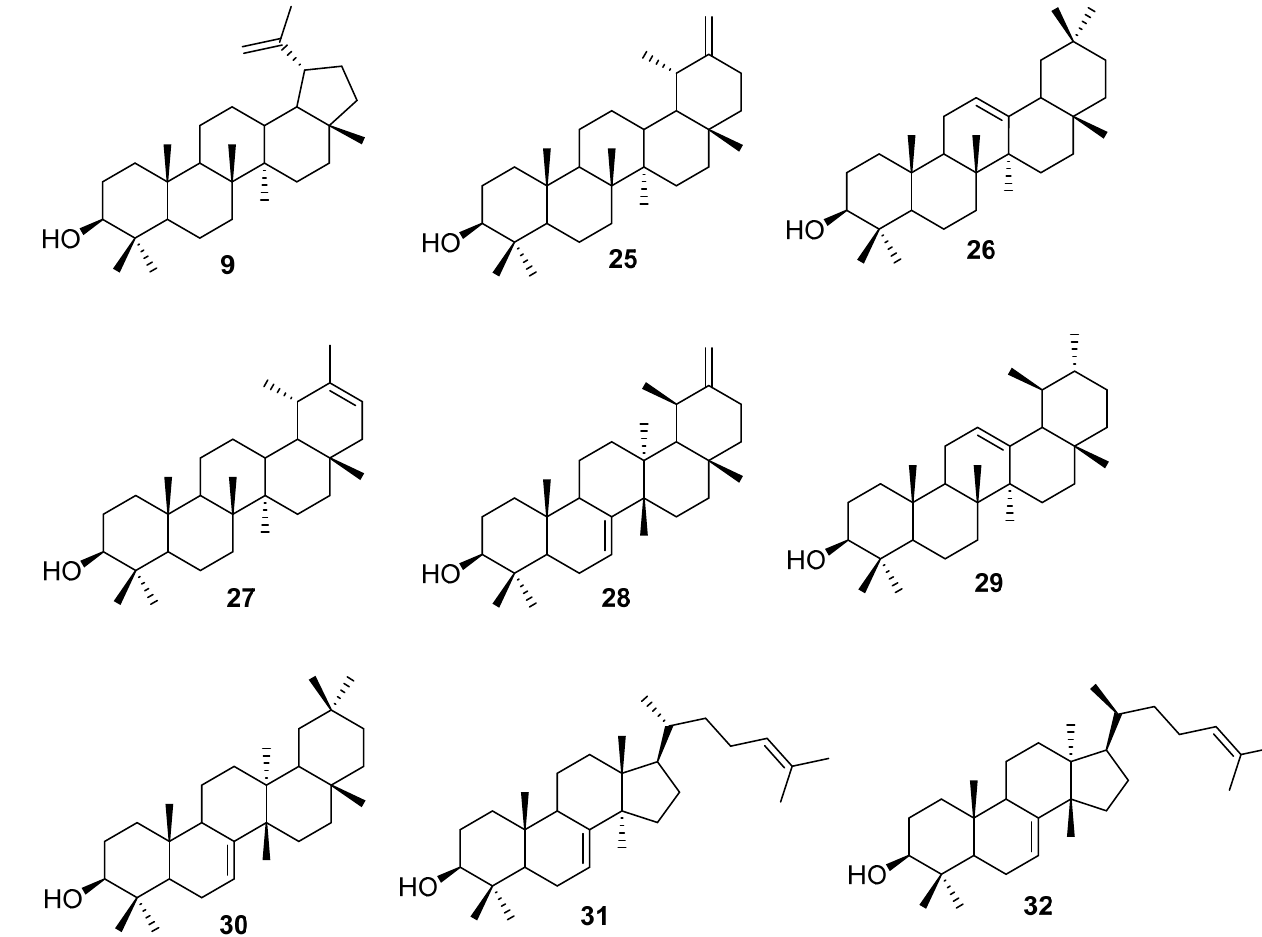
Figure 4. Chemical structures of lupeol ( 9 ), taraxasterol ( 25 ), β -amyrin ( 26 ), Ψ -taraxasterol ( 27 ), bauerenol ( 28 ), α -amyrin ( 29 ), multiflorenol ( 30 ), butyrospermol ( 31 ), and tirucalla-7,21-dien-3 β -ol ( 32 ).